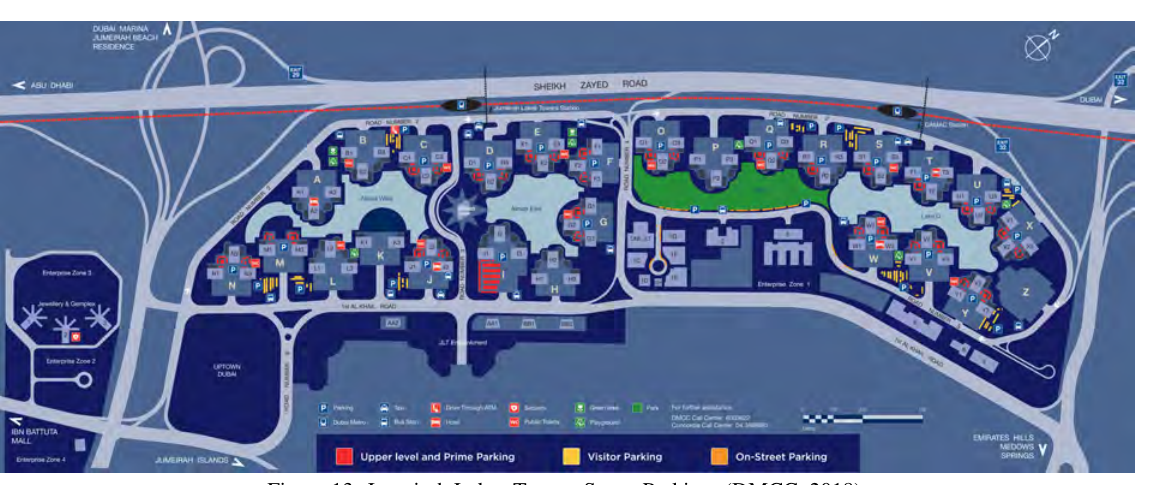
Figure 13. Jumeirah Lakes Towers Smart Parking. (DMCC,